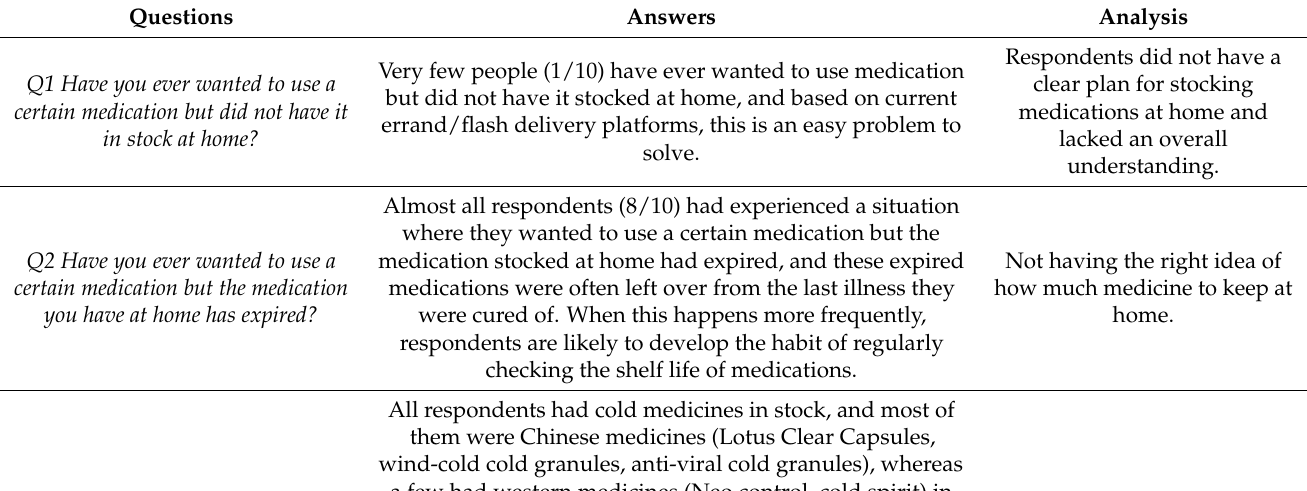
Table 6. Summary and analysis of user interview